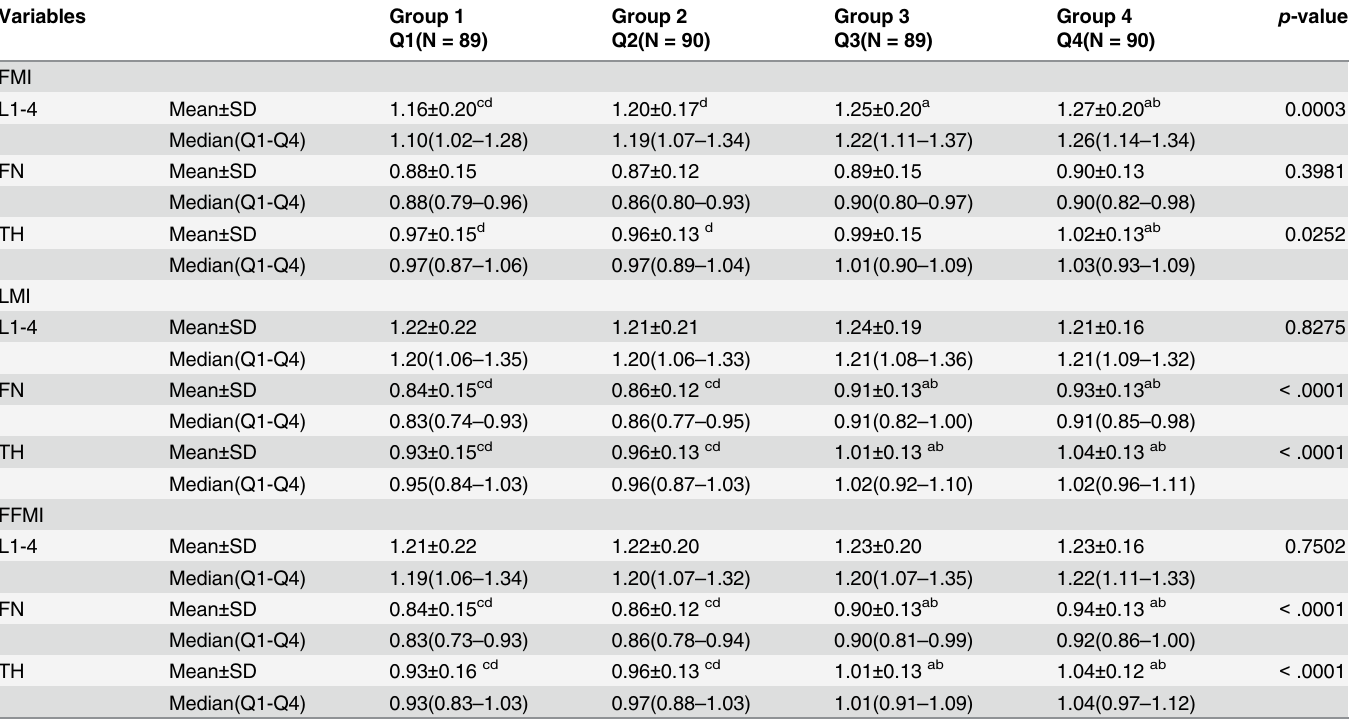
Table 5. Comparison the change of BMD at different site based on the quartile of FMI, LMI and